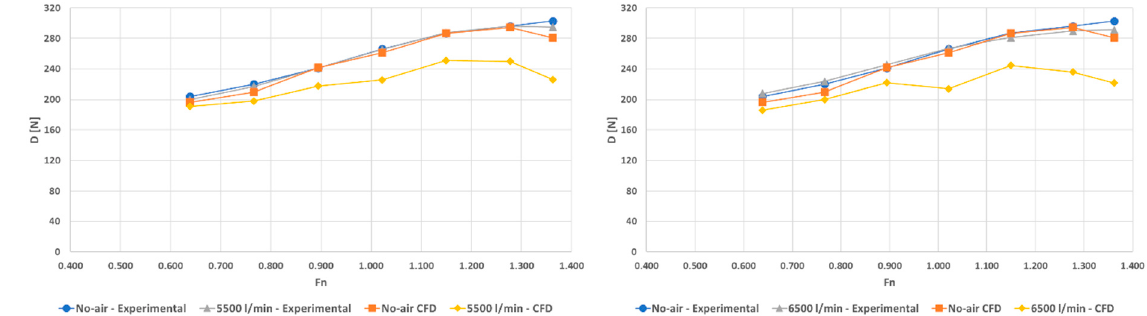
Figure 14. Experimental and CFD results to air injection 5500 L/min and 6500 L/min.